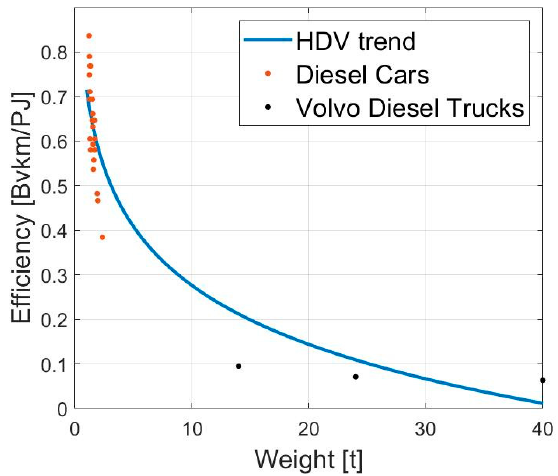
Figure 2. E ffi ciency trends for heavy-duty vehicles. Figure 2. Efficiency trends for heavy-duty vehicles. E ffi ciency (in Bvkm/PJ) for the di ff erent modes / technolgies in the current road transport